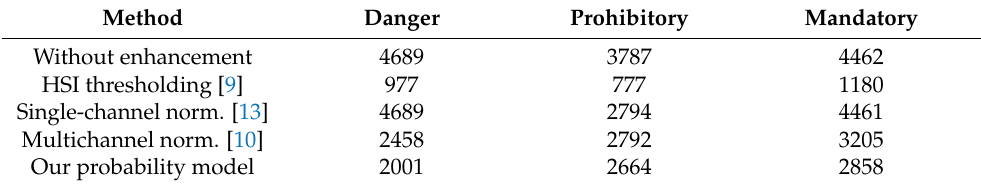
Table 4. The number of bounding boxes generated on GTSDB data.